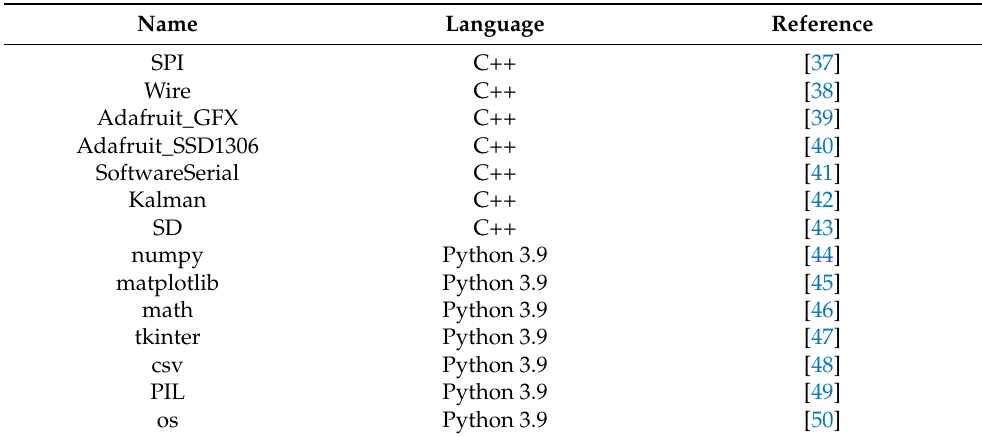
Table 2. Library